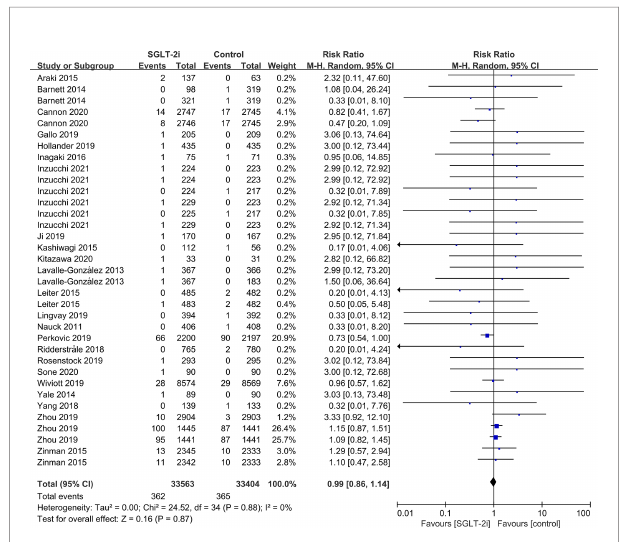
FIGURE 2 | Effect of SGLT-2i on incidences of cataracts compared with control in T2DM